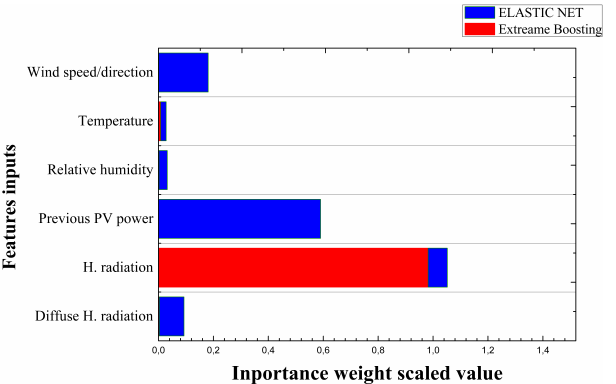
Figure 6. Coefficients of the nonlinear correlation between the PV power and related system attributes.